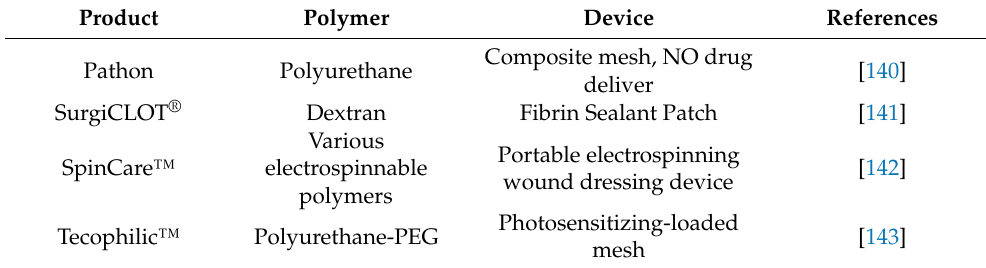
Table 6. Various electrospun commercial wound